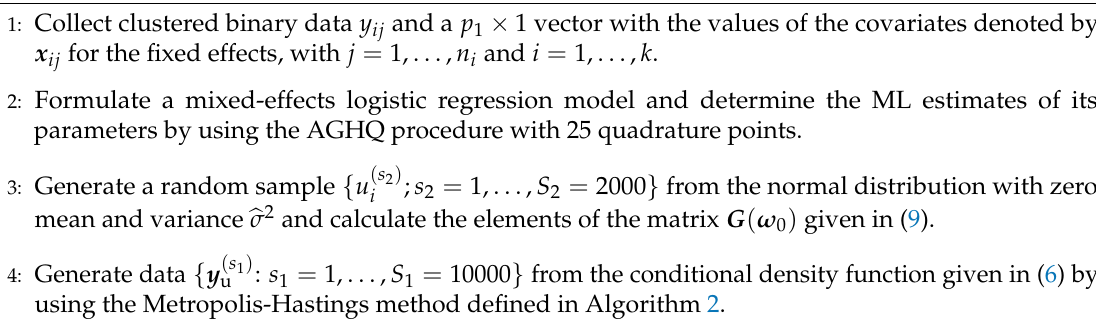
Algorithm 3 Procedure of sampling observations from the Metropolis–Hastings algorithm.